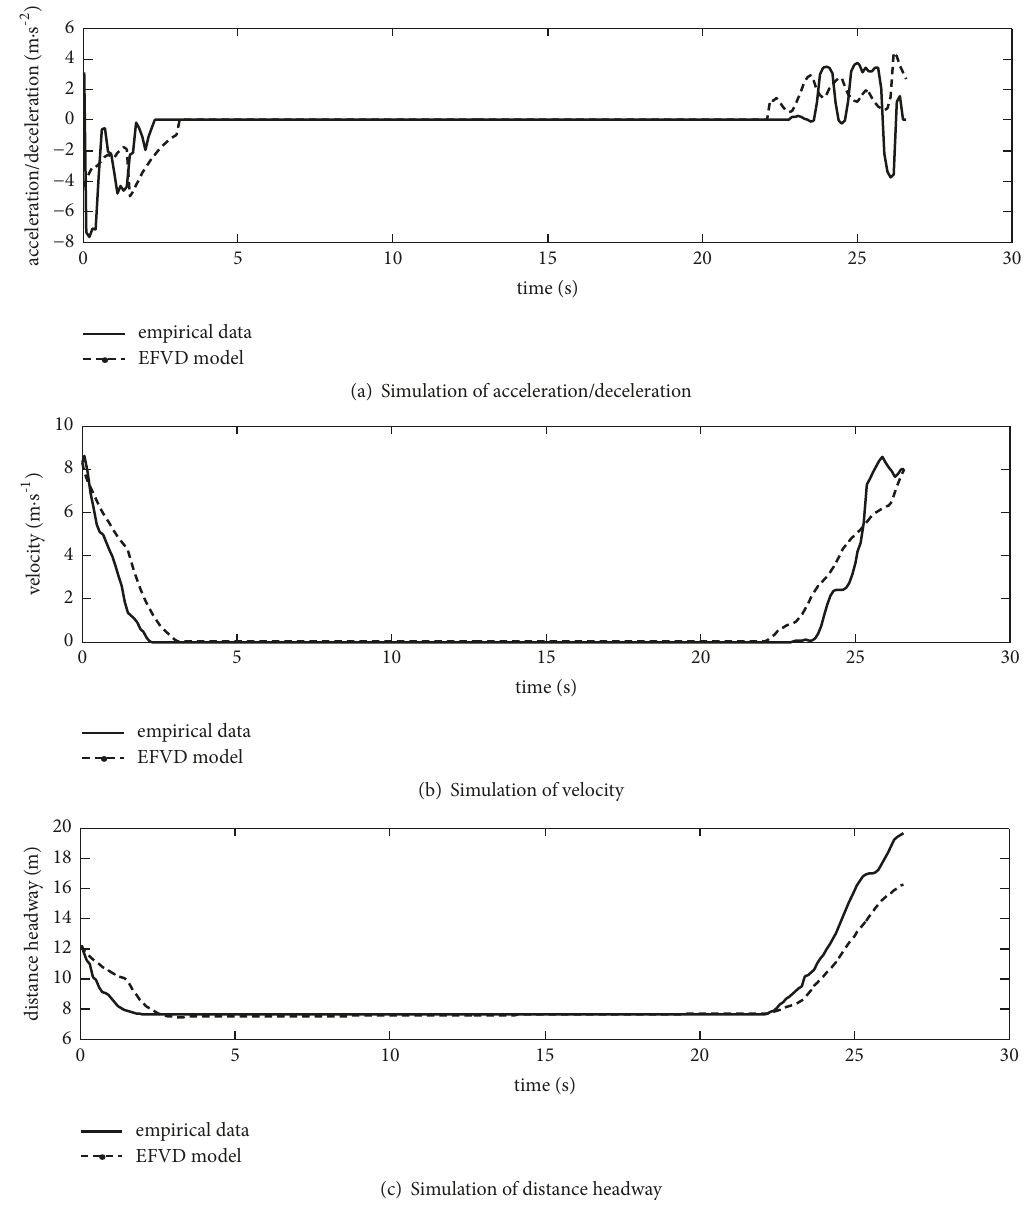
Figure 10: EFVD model simulations of car-following Process